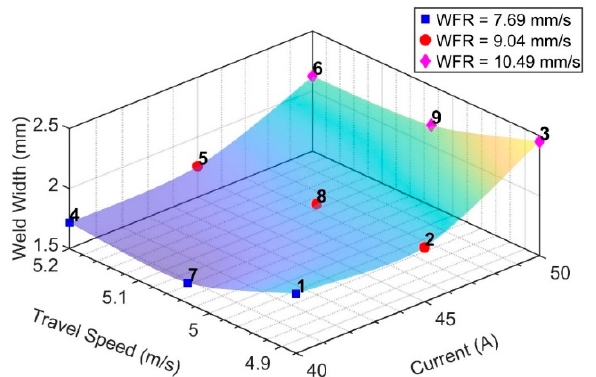
Figure 6. The transverse (perpendicular to the building direction) metallographic sections of the single-pass Inconel 718 samples. The processing parameters as well as characteristic measurements for the samples with corresponding parameter set numbers are presented in Table 5.